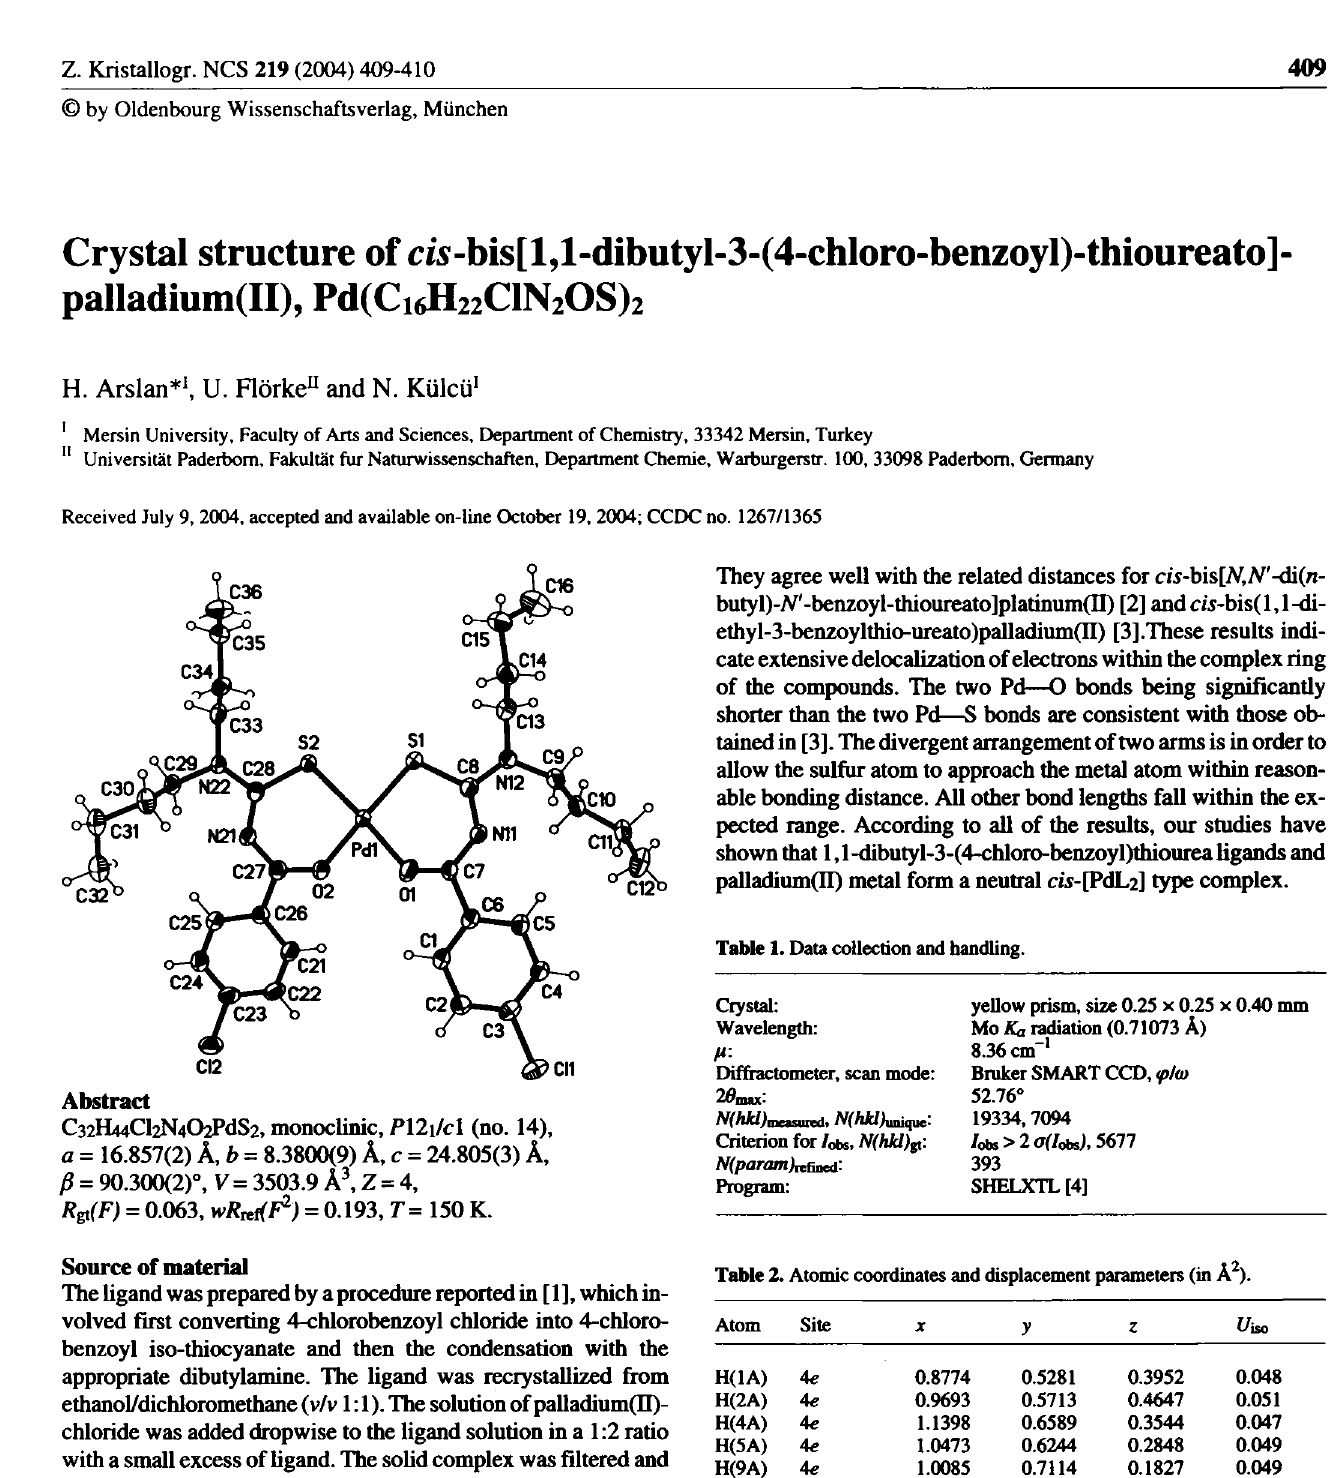
Table 2. Atomic coordinates and displacement parameters (in Â 2